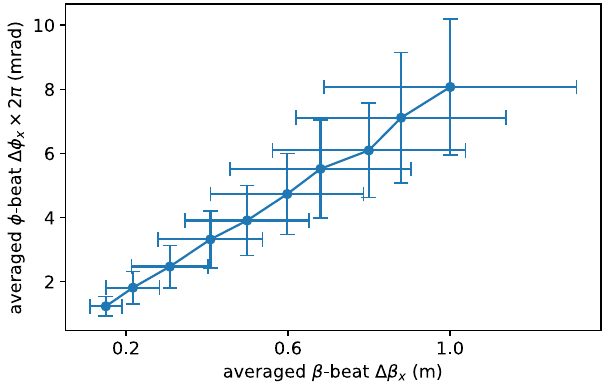
FIG. 2. The correlation of β x and ϕ x distortion distribution for the NSLS-II ring. This correlated distribution is calculated with the lattice model and could be used as another prior probability to eliminate incoherent measurement data. The farther away from the line, the less reliable the measured data is. Once a data point is not within the range of the error bars, it should be removed from the data